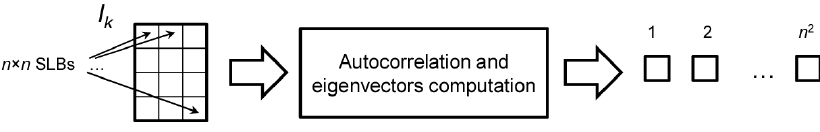
Figure 2. Diagram showing the main elements involved in key generation.